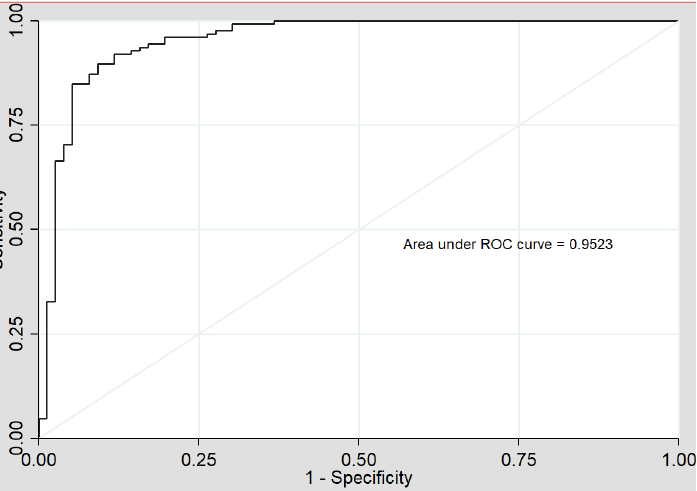
Figure 1. Model 1 ROC (receiver operating curve) analysis (sdLDL-C, HDL-Tg, lLDL-P). AUC (area under the curve).